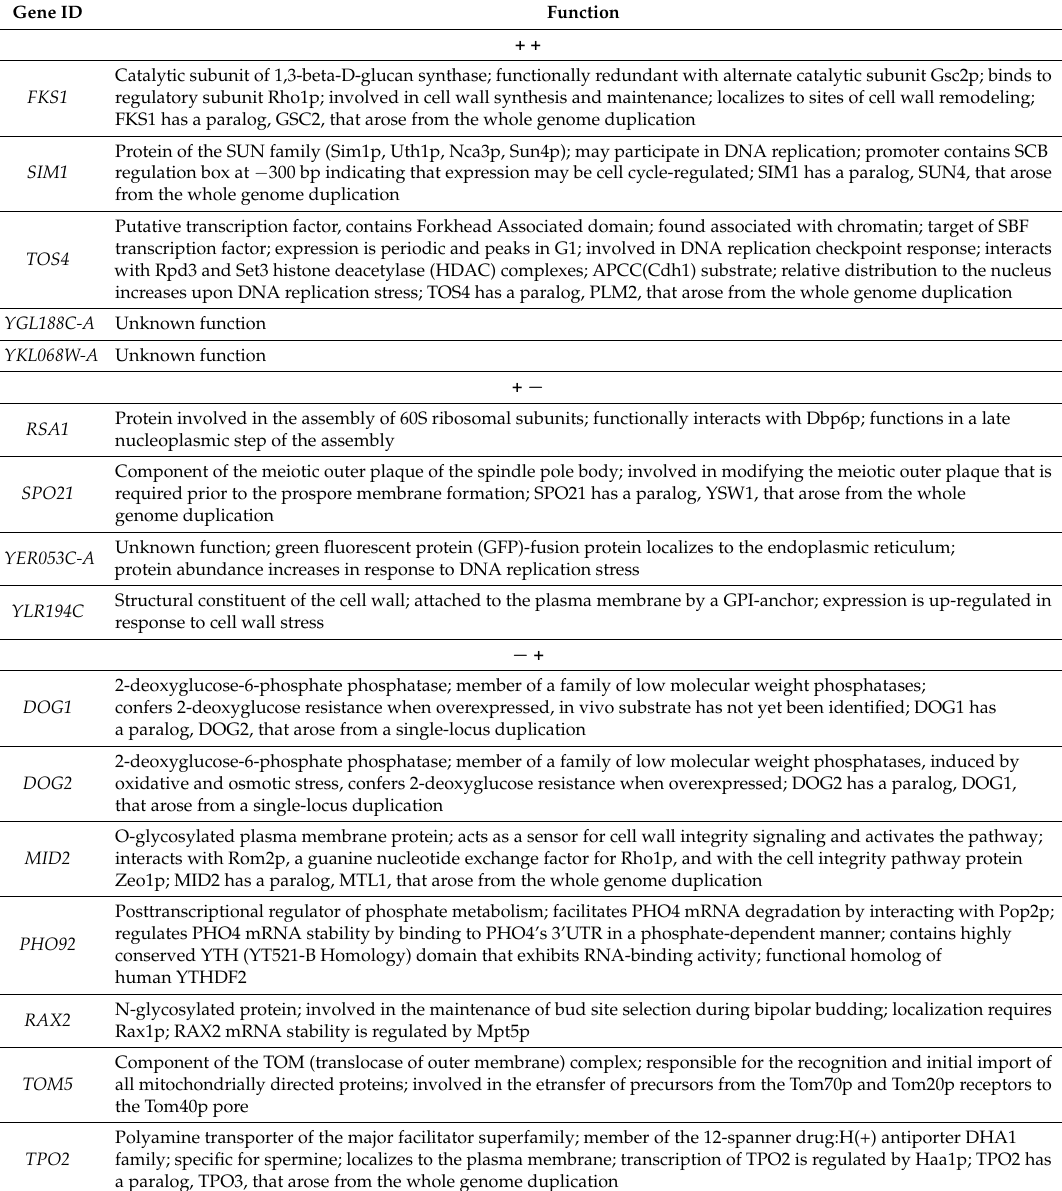
Table 1. Genes selected after the comparison of the phenotype screening and microarray analysis, represented in Figure 4. (+ +) genes that showed a tolerant knock-out phenotype and were up-regulated in the wild type strain; (+ − ) genes that showed a tolerant knock-out phenotype and were down-regulated in the wild type strain; ( − +) genes that showed a sensitive knock-out phenotype and were up-regulated in the wild type strain; ( − − ) genes that showed a sensitive knock-out phenotype and were down-regulated in the wild type